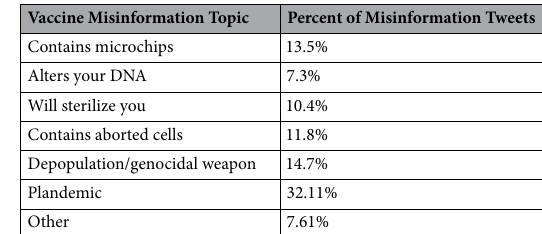
Table 2. Prevalence of specific subtopics in Far Right vaccine misinformation tweets. Percentages may surpass 100% as a tweet can be flagged for more than one term or phrase.